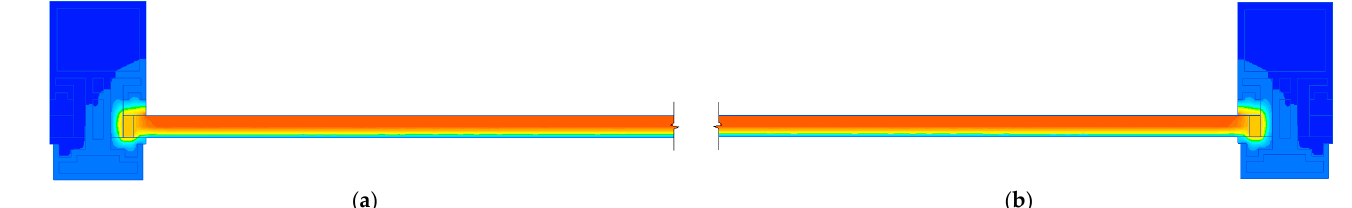
Figure 8. Calculation scheme of the ( a ) left side and ( b ) right side of the glazing structure of samples No. 2.1–No. 2.3.